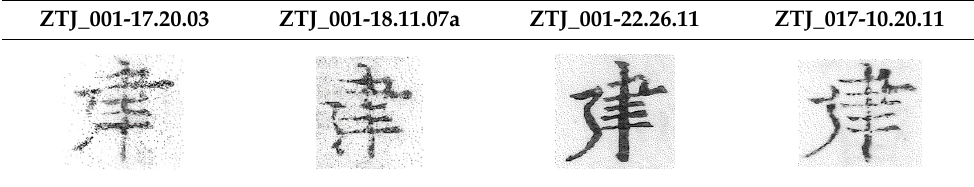
Table 1. Four examples of the tabooed character jiàn 建 in the Goryeo edition of the ZTJ . ZTJ_001-17.20.03